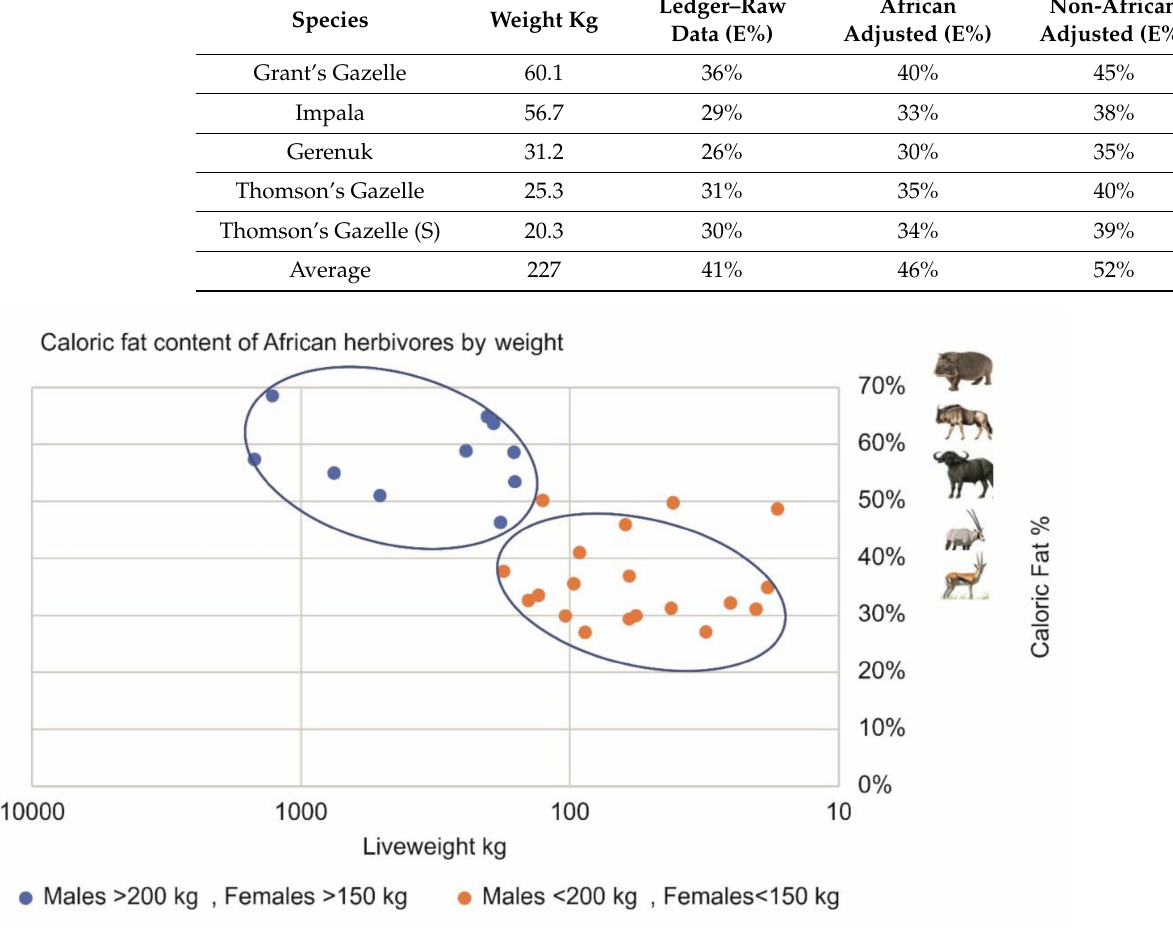
Figure 4. Percent of fat content as a function of body weight in African herbivores. Based on [31]. Data in